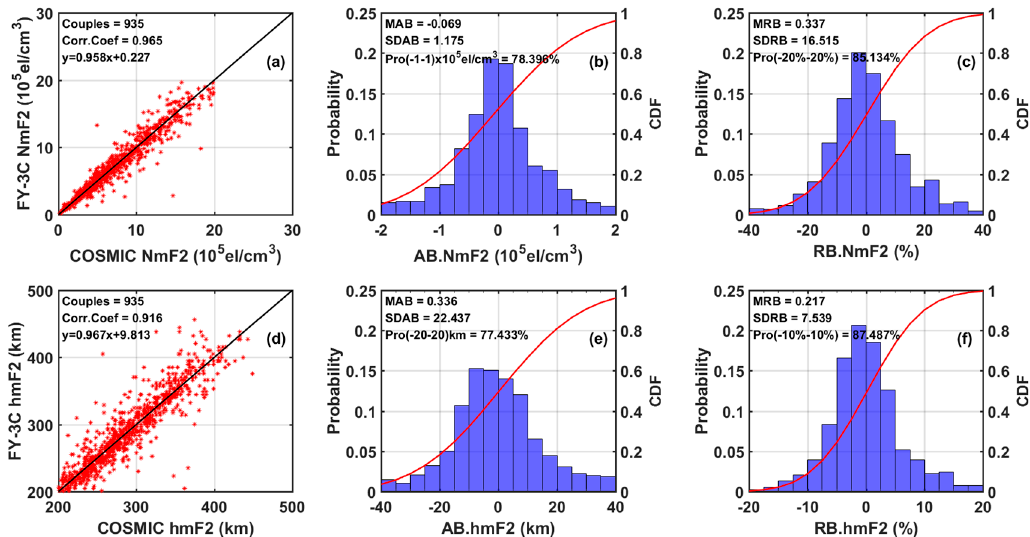
Figure 6. The comparison of FY-3C RO-derived ICPs with ICPs derived from COSMIC RO during 2014–2017 based on the collocation space and time windows of (3°, 5°, 1 h) and the constraint of DAOP ≤ 20° for the statistical parameters of ( a, d ) correlation coefficients, ( b, e ) absolute biases, and ( c, f ) relative biases.